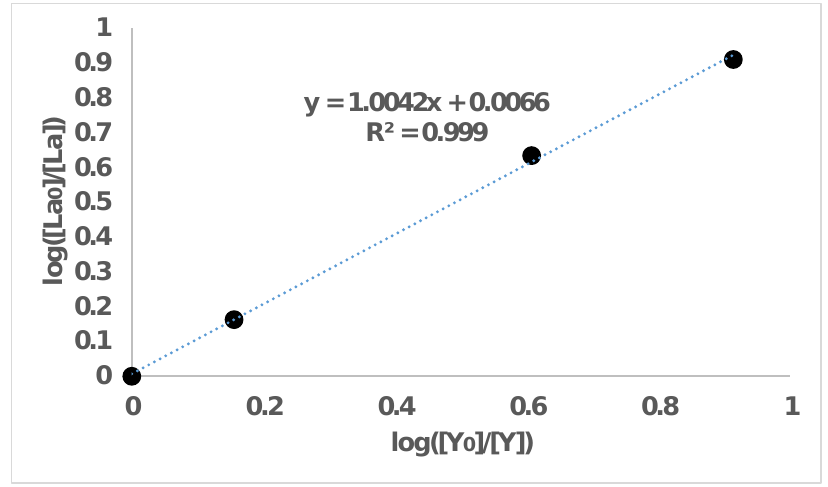
Figure 2. Enrichment of La against Y: logarithm of the quotient of the starting concentration and final concentration for each rare